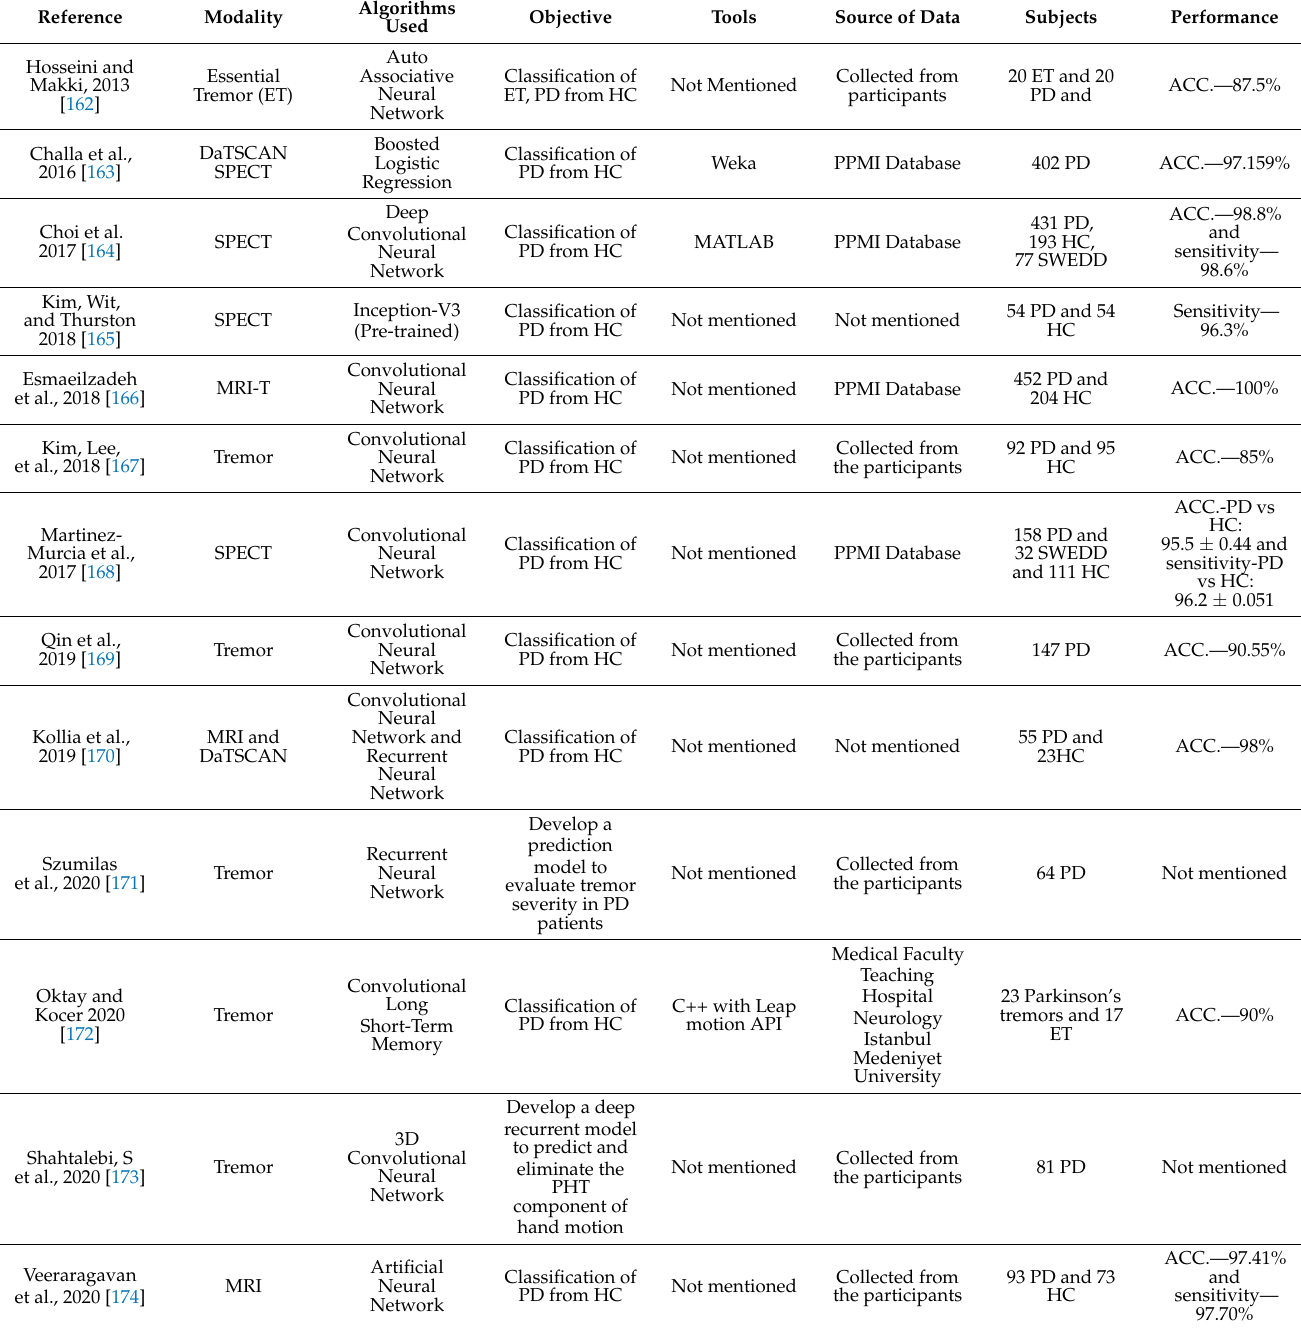
Table 4. Comparative research on Parkinson’s disease diagnosis using machine learning approaches